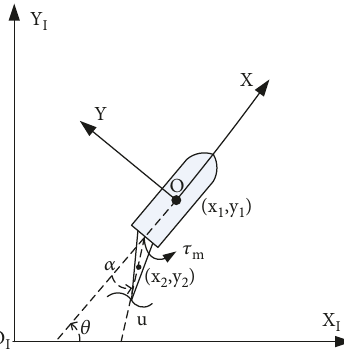
Figure 2: Robotic fi sh in a